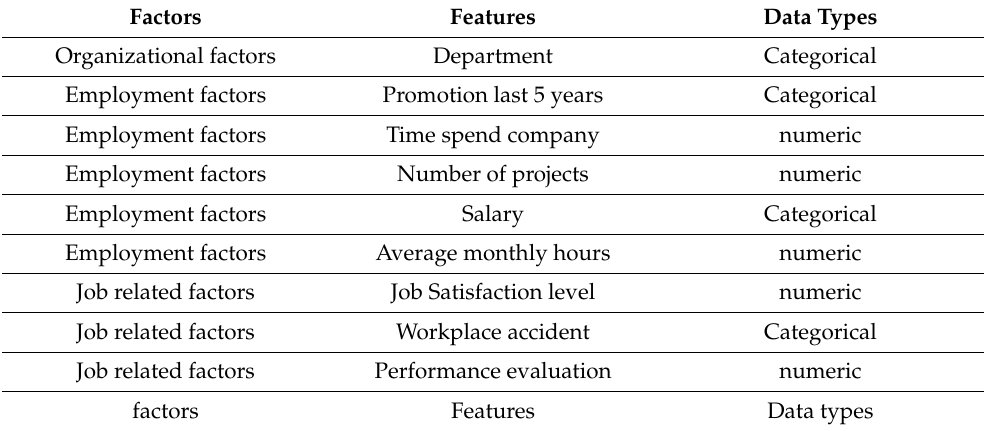
Table 1. Churn analysis features categorization.